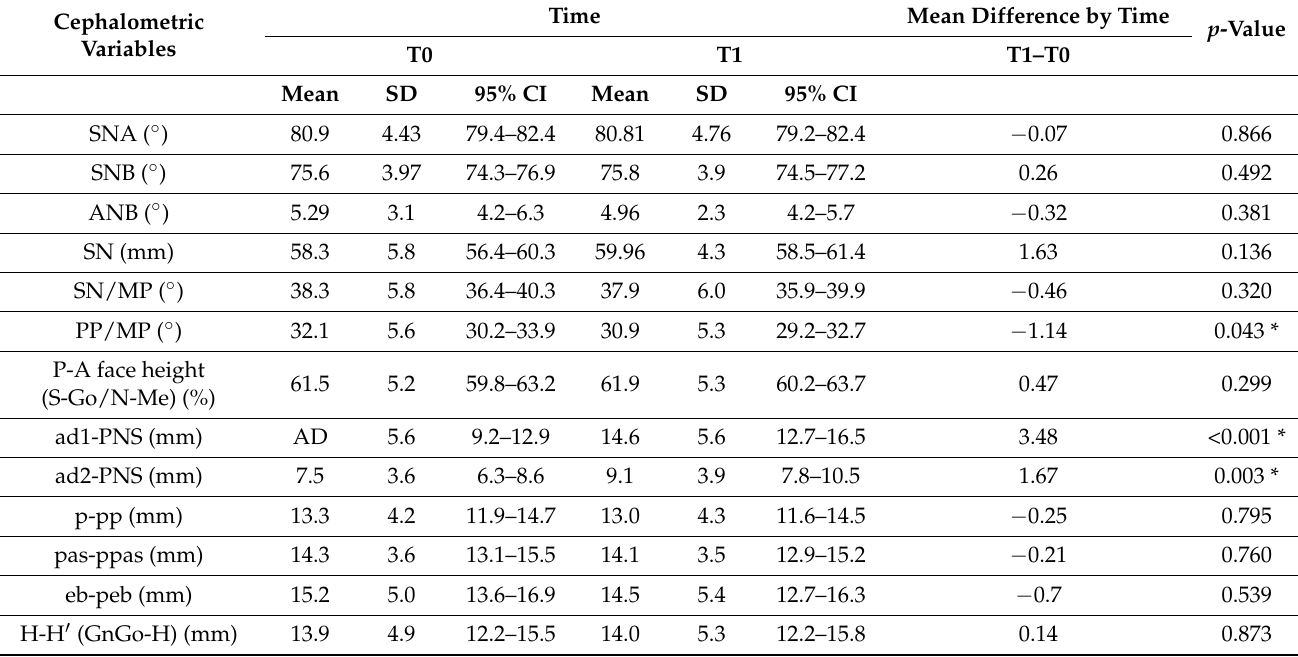
Table 2. Cephalometric variables in treated group at time T0 and T1, expressed as mean and standard deviation (SD) and their 95% confidence interval (95%